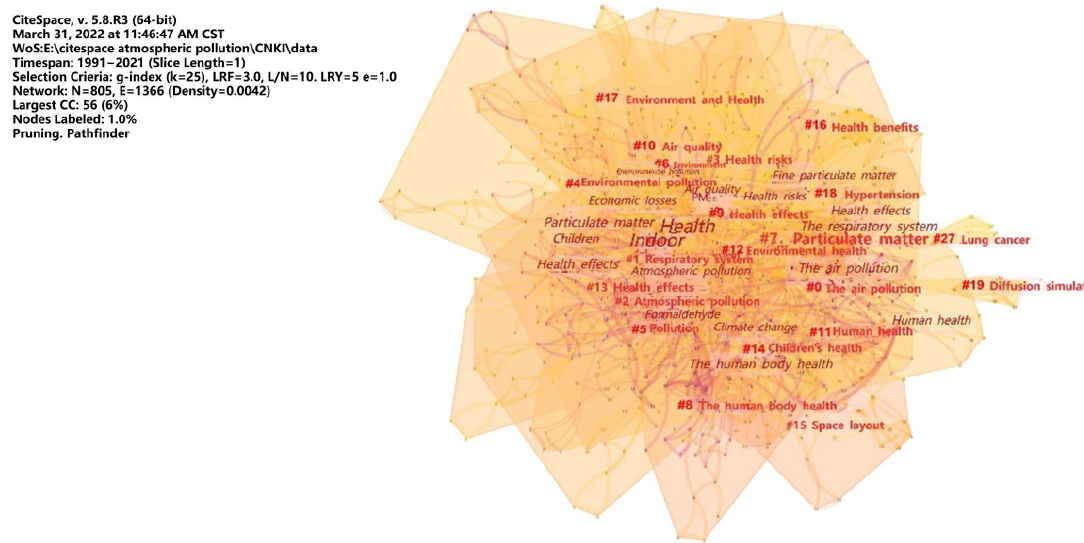
Figure 8. Chinese keyword clustering view.